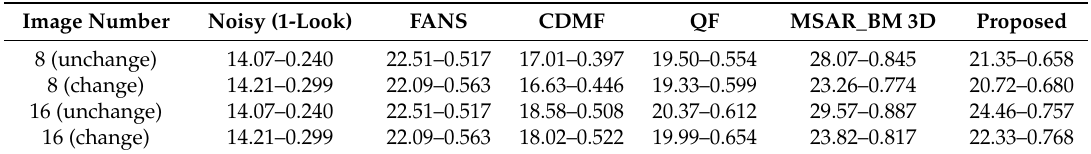
Table 1. The quantitative results of different methods on synthetic aperture radar (SAR) images (peak signal-to-noise ratio (PSNR) and structural similarity (SSIM), PSNR-SSIM).